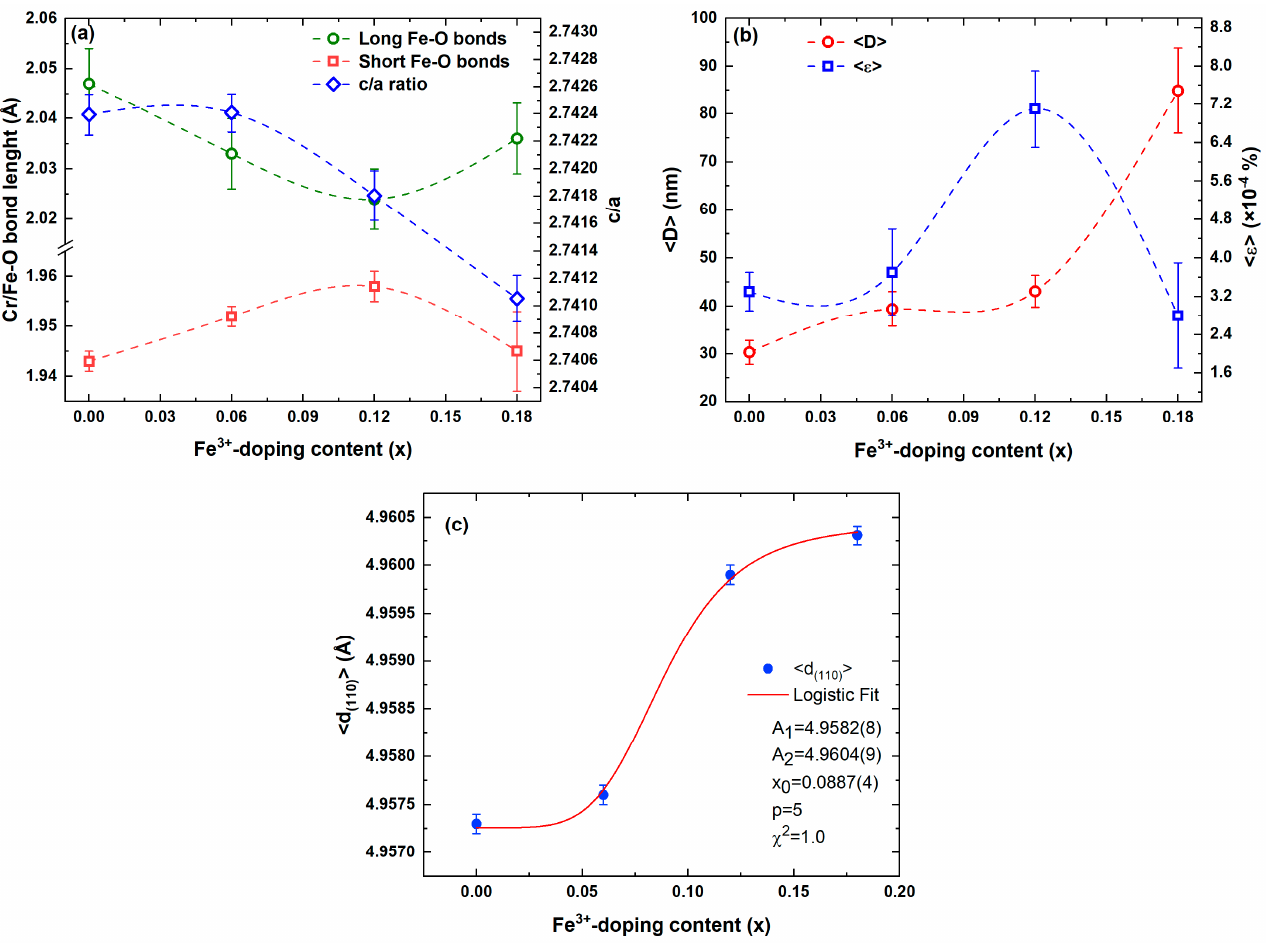
Figure 2. ( a ) Fe–O bond length and c / a ratio, ( b ) average crystallite size (< D >) and microstrain (< ε >), and ( c ) Cr–Cr distance in the (110) plane for the Cr 2 − x Fe x O 3 (0.0 ≤ x ≤ 0.18) nanoparticles. Hence, we can notice in the first approximation that the octahedral site distortion seems directly linked to the microstrain, which is directly governed by the Fe-doping- induced crystal growth. The higher distortion of the octahedral sites for the Cr 1.88 Fe 0.12 O 3 nanoparticle is because of a decrease in the microstrain. According to the Cr–Cr distance values reported in Table 1, the corresponding Cr–Cr distance in the (110) plane versus the Fe doping content of the Cr 2 − x Fe x O 3 (0.0 ≤ x ≤ 0.18) nanoparticles is illustrated in Figure 2c. The solid red curve indicates the fit of the data to the theoretical curve for a logistic function, as described in Equation (3):